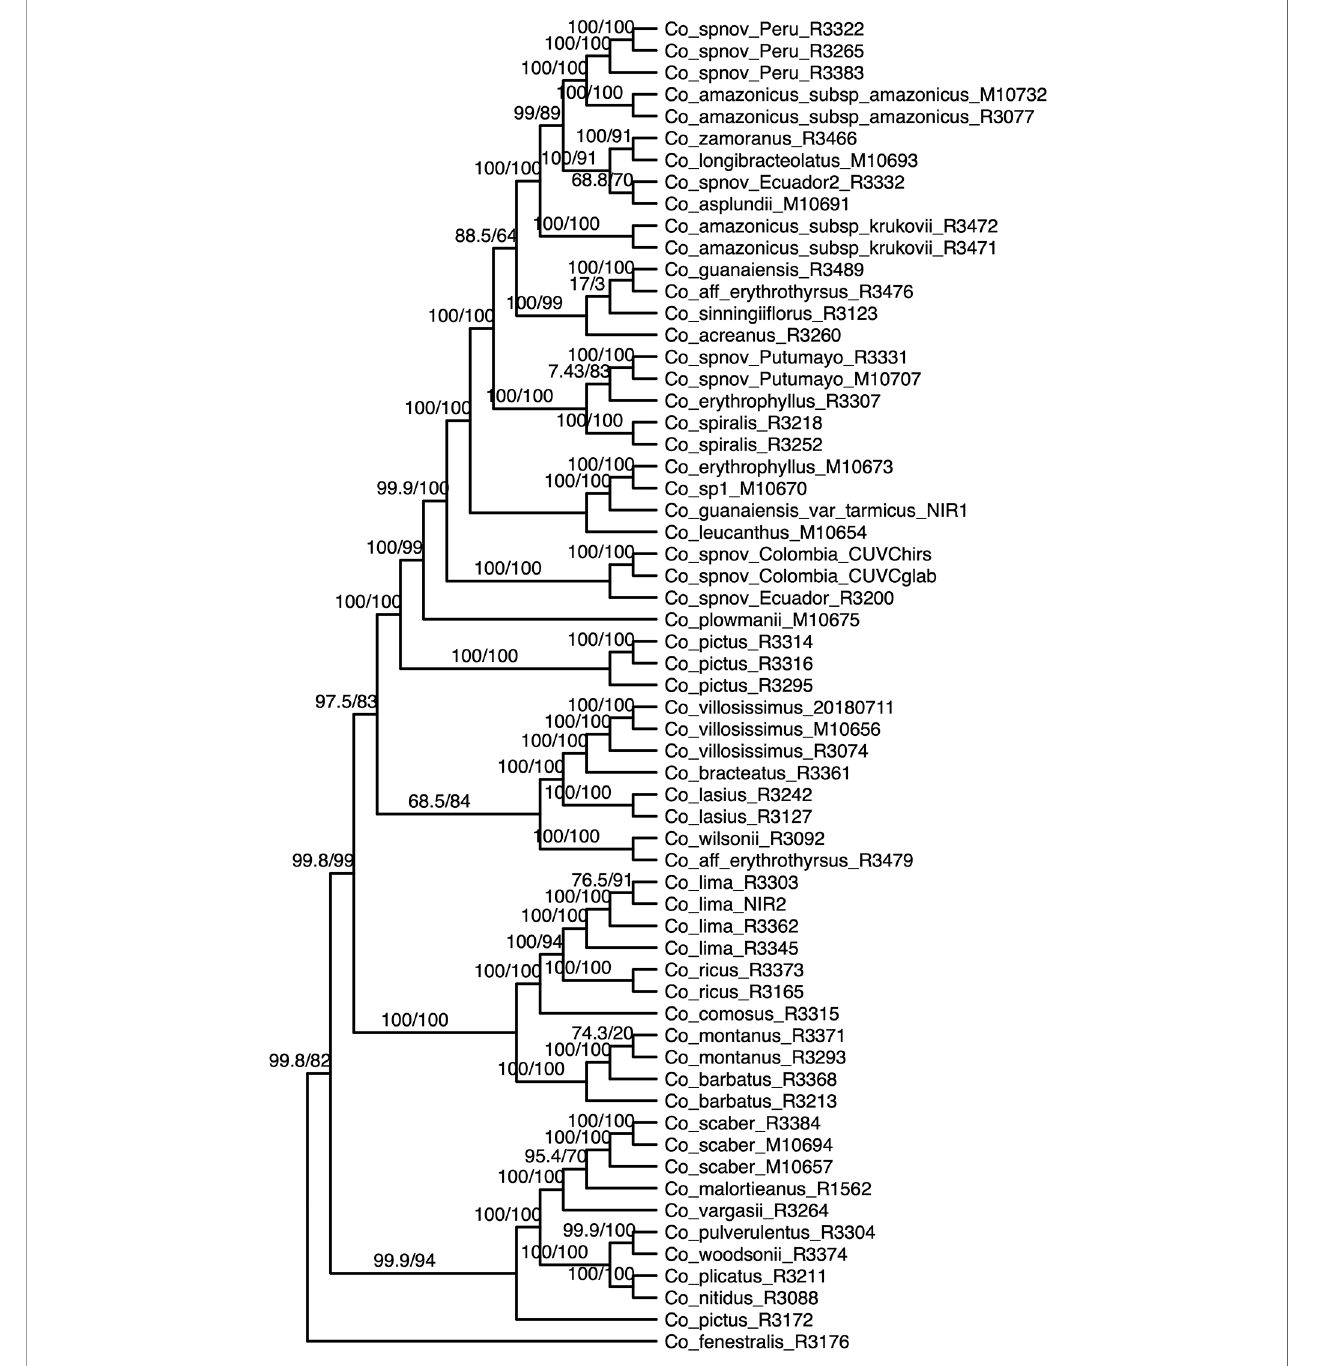
FIGURE 3 | Phylogenetic reconstruction with the concatenation of 832 loci analyzed in IQ-Tree; the values above the branches are the result of the SH-aLRT (above 80 are considered strongly supported) and ultrafast bootstrap support (above 95 are considered strongly supported) showing high support values in most of the branches. Equal branch lengths were used to allow the reader to distinguish support values; branch lengths are depicted in Figure 6 The changes involve shifts to melittophilous pollination improve likelihood signi fi cantly ( c 2 [1] = 0.916, p = 0.339). syndromes and subsequent regains of ornithophilous fl owers. Posterior probabilities indicate multiple changes in pollination Our results suggest that the most recent common ancestor of syndromes during the evolutionary history of Costus , with shifts all Neotropical Costus species was most likely ornithophilous occurring at least four times within the Neotropical lineage.